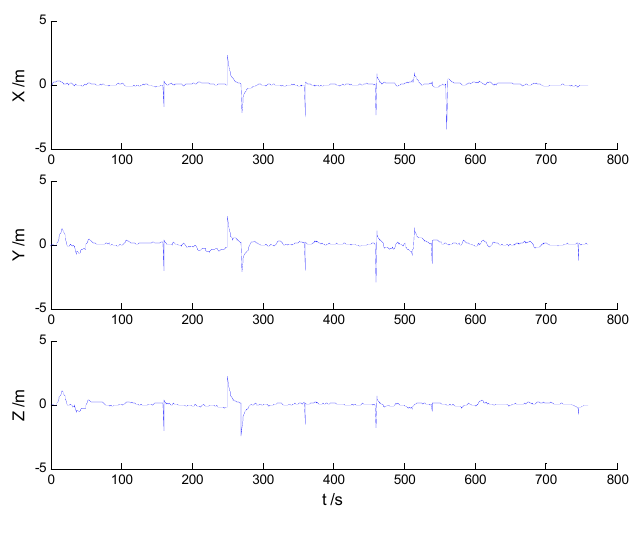
Figure 11. Position errors of the AKF algorithm.